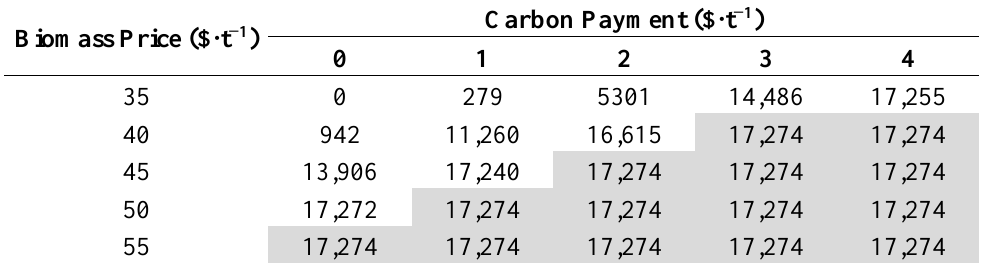
Table 4. Combined effects of biomass price and carbon offset payments on the amount of economically feasible area (ha) including property taxes.